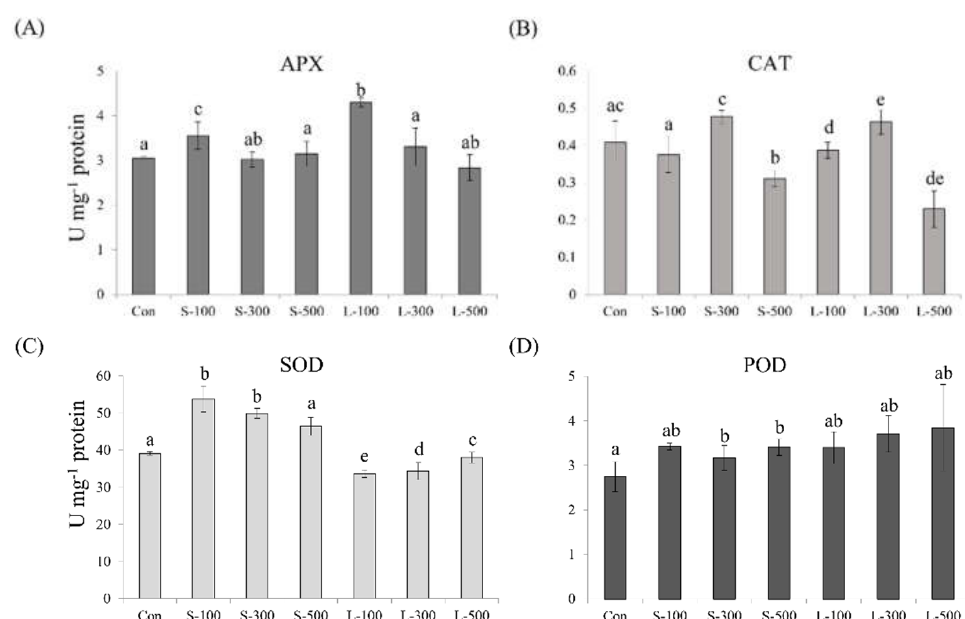
Figure 7. Short- and long-term gamma irradiation effects on ( A ) APX, ( B ) CAT, ( C ) SOD, and ( D ) POD antioxidant enzyme activities. Each bar represents the mean ± SD ( n = 3). Values with different letters are significantly different using Duncan’s multiple range test ( p < 0.05).